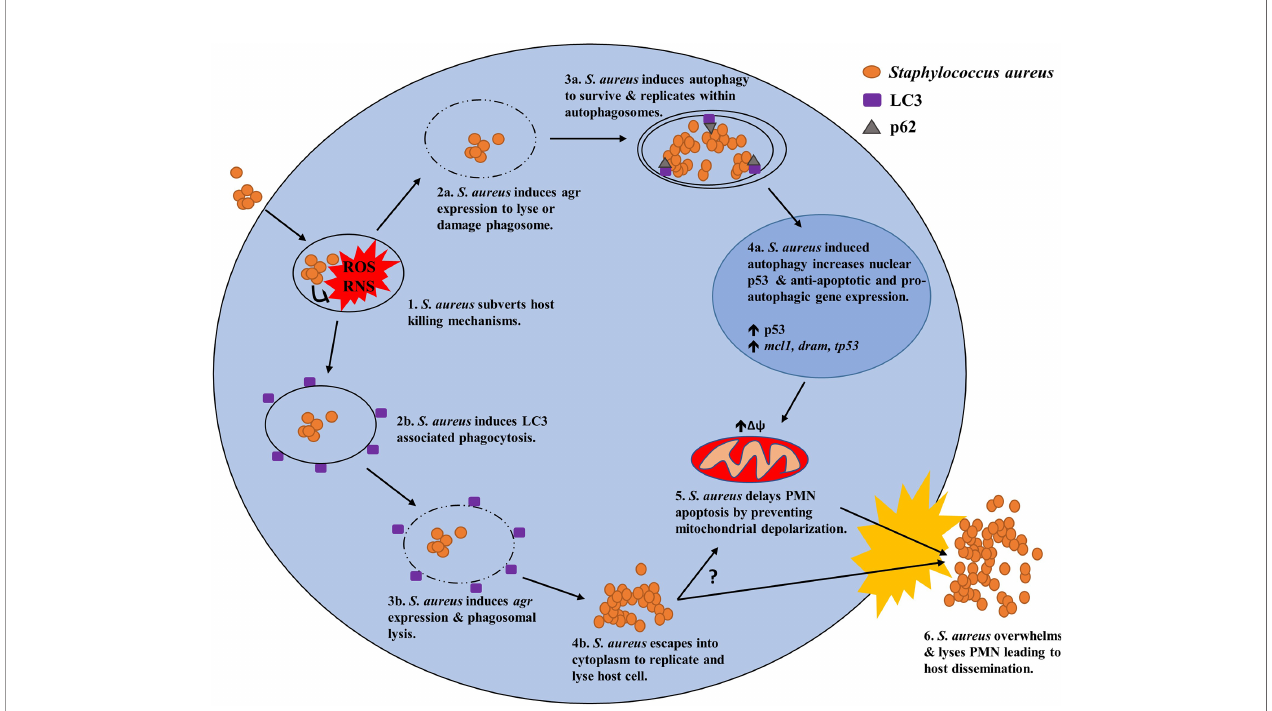
FIGURE 3 | Potential mechanisms of S. aureus to manipulate host autophagy in PMN for intracellular survival. (1.) Upon phagocytosis by PMN, S. aureus subverts host killing mechanisms such as ROS generation and persists intracellularly by manipulating canonical or non-canonical (LAP) autophagy. (2a.) Using canonical autophagy, S. aureus lyses or damages the host phagosome using an agr regulated toxin. (3a.) Phagosomal lysis/damage induces host autophagy enabling its uptake into an autophagosome as its primary intracellular niche. (4a.) Induction of the canonical autophagy pathway leads to increased levels of nuclear p53 and anti-apoptotic and pro-autophagic gene expression of mcl1 and dram respectively. (5.) Increases in anti-apoptotic factors prevents mitochondrial depolarization and subsequent induction of the apoptotic pathway resulting in prolonged PMN survival. (6.) Eventually, S. aureus exhausts its intracellular niche and overwhelms the host cell resulting in cell lysis and host dissemination. (2b.) Alternatively, S. aureus can utilize non-canonical autophagy via LAP were the bacterium resides within LC3 decorated phagosomes as its primary niche. (3b.) S. aureus uses an agr regulated toxin to avoid bacterial killing before lysing the LC3 decorated phagosome. (4b.) S. aureus then escapes into the cytosol where it then replicates. (5.) It is unknown whether this mechanism can lead to increased PMN survival however a link between the two may exist. (6.) Ultimately S. aureus overwhelms the host cell leading to cell lysis and host